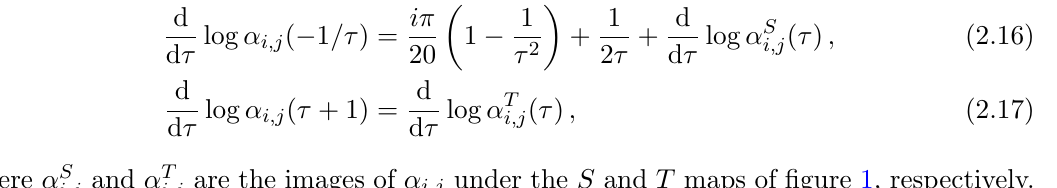
Figure 1 . Graph illustrating the automorphisms of the set of seed functions (cid:11) i;j ( (cid:28) ), de(cid:12)ned in eq. (2.15), under the actions of (cid:0) 5 ’ A 5 generators S and T . and T 5 applied to each element correspond to the identity. Taking logarithmic derivatives, one